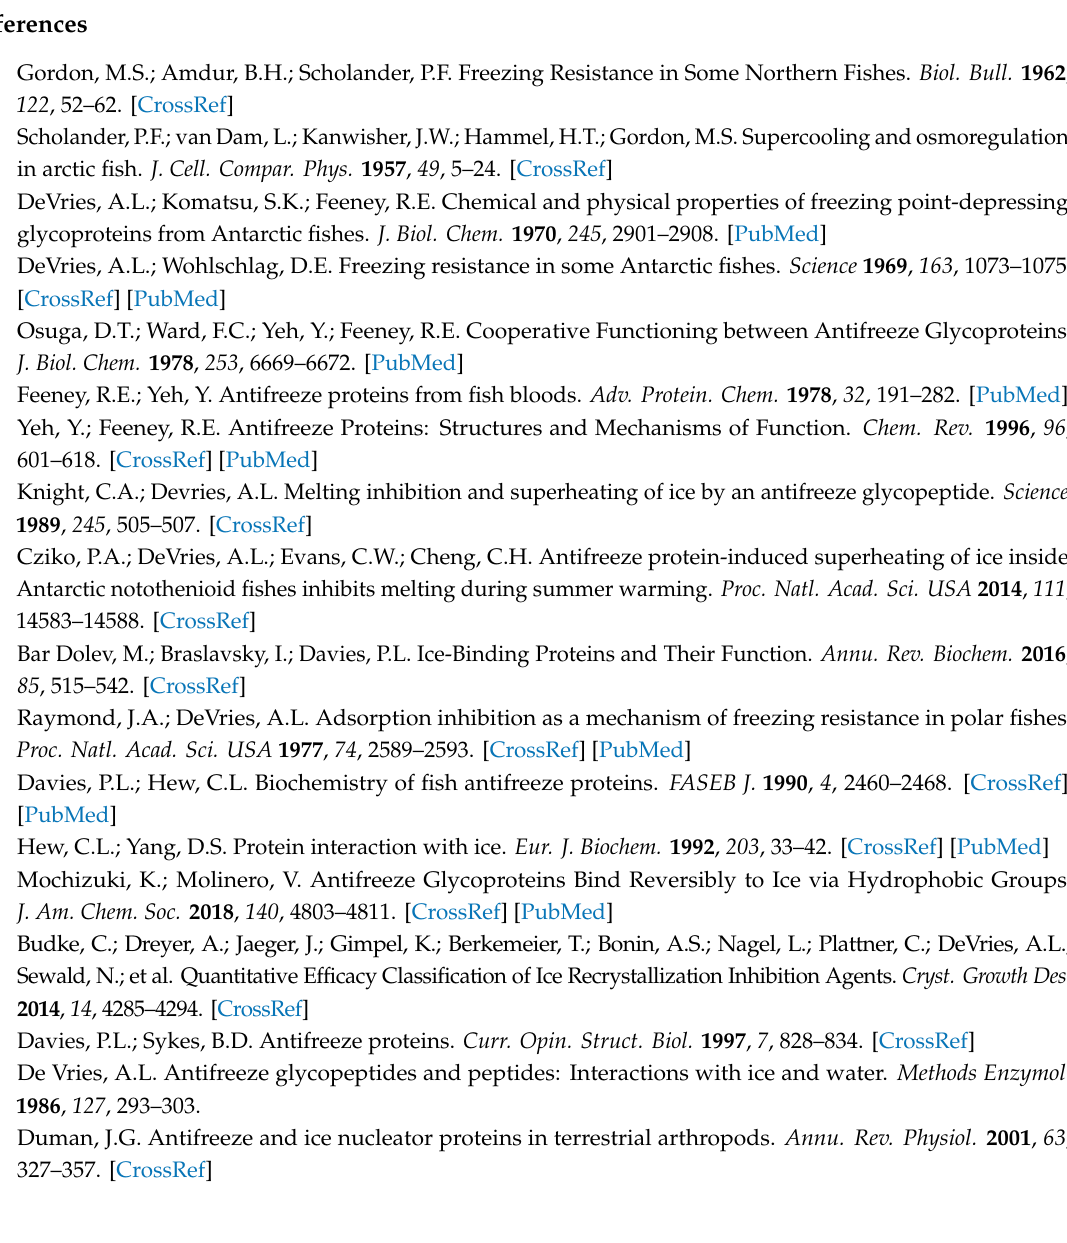
Figure S1: The TOCSY-NOESY crosswalk of AFGP8-BS, Figure S2: The TOCSY-NOESY crosswalk of AFGP8-TB, Figure S3: The distribution of distance constraints, Figure S4: Comparison of the NMR determined Rg values of AFGP8-BS and AFGP8-TB, Table S1: Three bond J-coupling constants ( 3 J HN α ) of AFGP8, Table S2: Chemical shift assignments of the hydroxyl protons and Table S3: Number of NOEs and upper limit distance